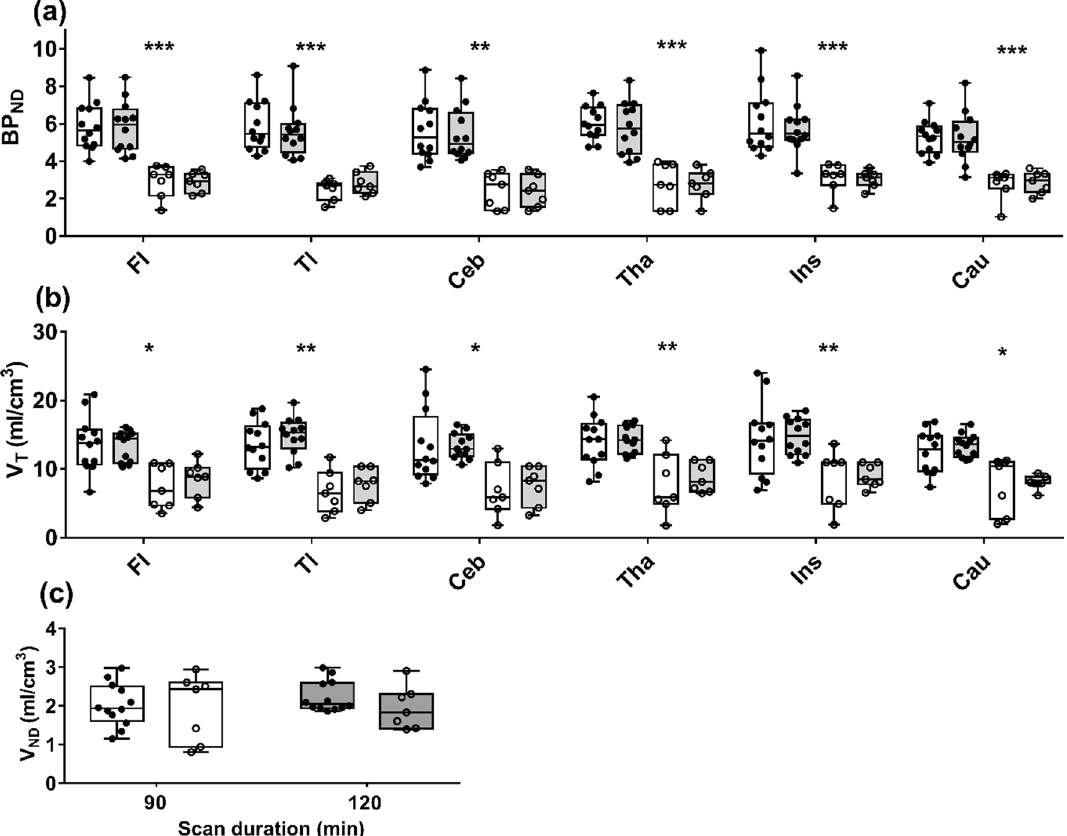
Fig. 2 a Regional BP ND estimates from SIME for scan time durations of 90 and 120 min (open box plots and dark gray box plots, respectively). b Corresponding V T estimates and c V ND estimates for the same scan durations. Data are presented as box–whisker plots with the median indicated by a black line. Results were separated based on binding affinity: filled circles represent HABs and open circles represent MABs. Significant between HABs and MABs are indicated by asterisk (* p < 0.05, ** p < 0.01, *** p <